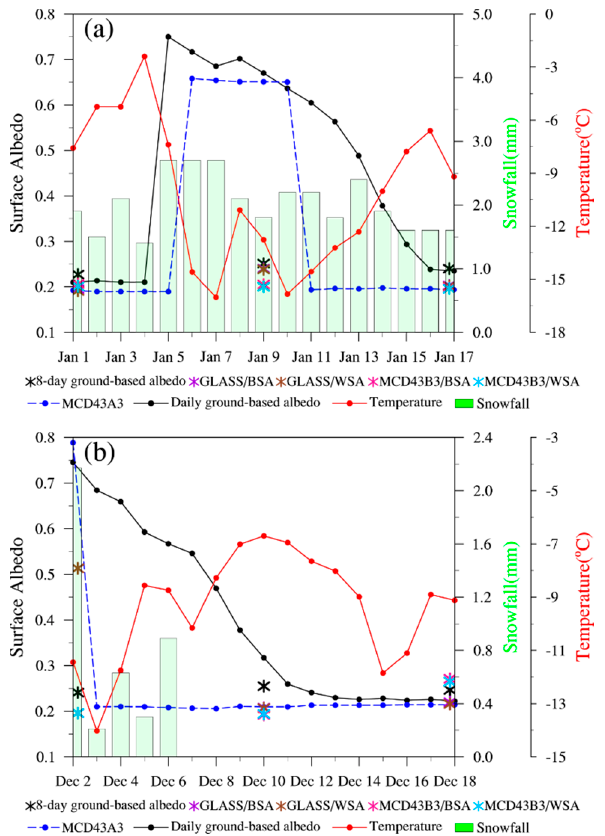
Figure 7. Time series of ground-based albedo, snowfall (units: mm), temperature (units: °C), and satellite-based albedo at the ( a ) Maqu site from January 1 to 17, 2015 and ( b ) Maduo site from December 2 to 18, 2016.